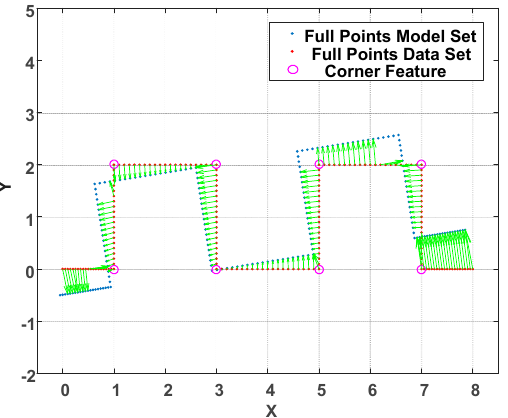
Figure 5. Incorrect point registration caused by the nearest neighbor search (NNS) Iterative Closest Point (ICP) algorithm.